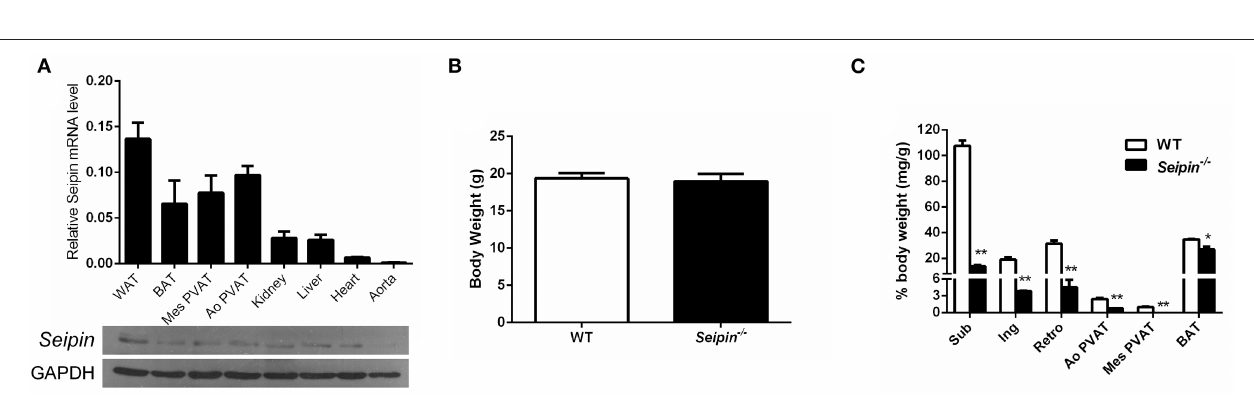
FIGURE 2 | Reduced PVAT mass in Seipin deleted mice. (A) Detection of Seipin mRNA and protein expression in various tissues of WT mice. N = 6. (B) Body weight and (C) Mass of fat pad and PVAT in 6-month-old Seipin − / − and WT mice. Brown adipose tissue (BAT), White adipose tissue (WAT), aortic perivascular adipose tissue (Ao PVAT), mesenteric PVAT (Mes PVAT). Data are expressed as mean ± SEM. N = 6. * P < 0.05, ** P < 0.01 for Seipin − / − mice vs.